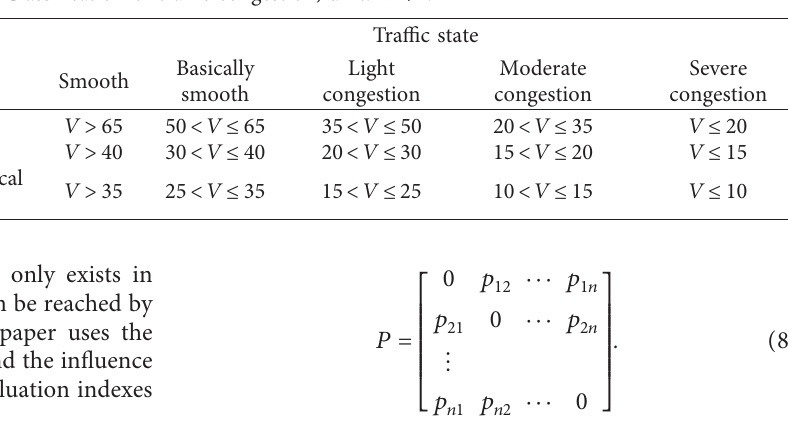
Table 2: Classification of traffic congestion, unit: